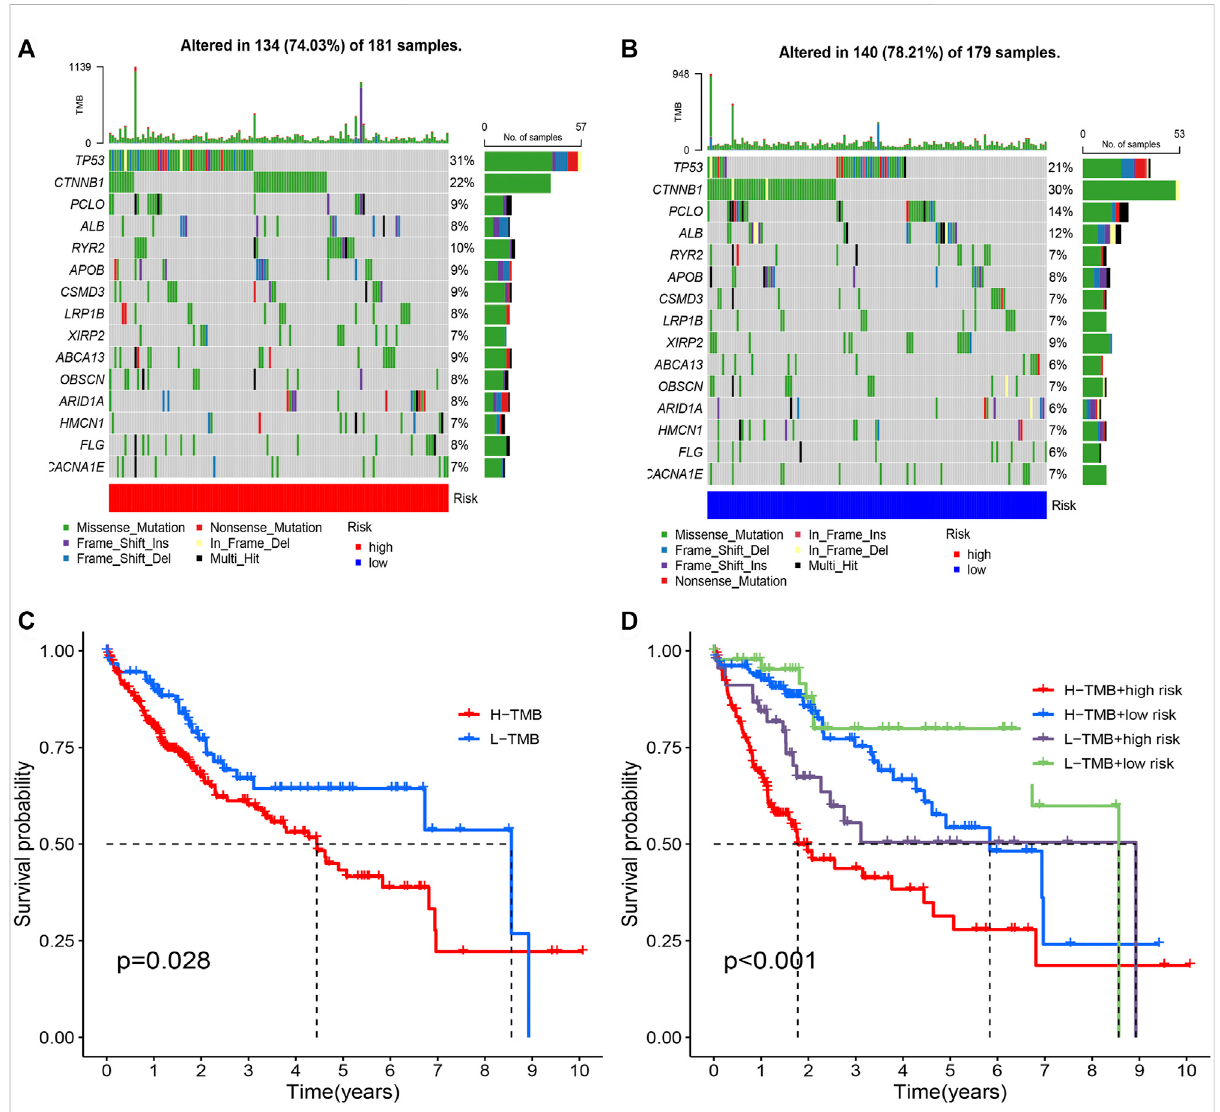
FIGURE 9 Tumor mutation analysis in different risk groups. (A) The mutation waterfall map of high-risk group. (B) The mutation waterfall map of high-risk group. (C) Survival analysis of two groups. (D) Survival analysis of four